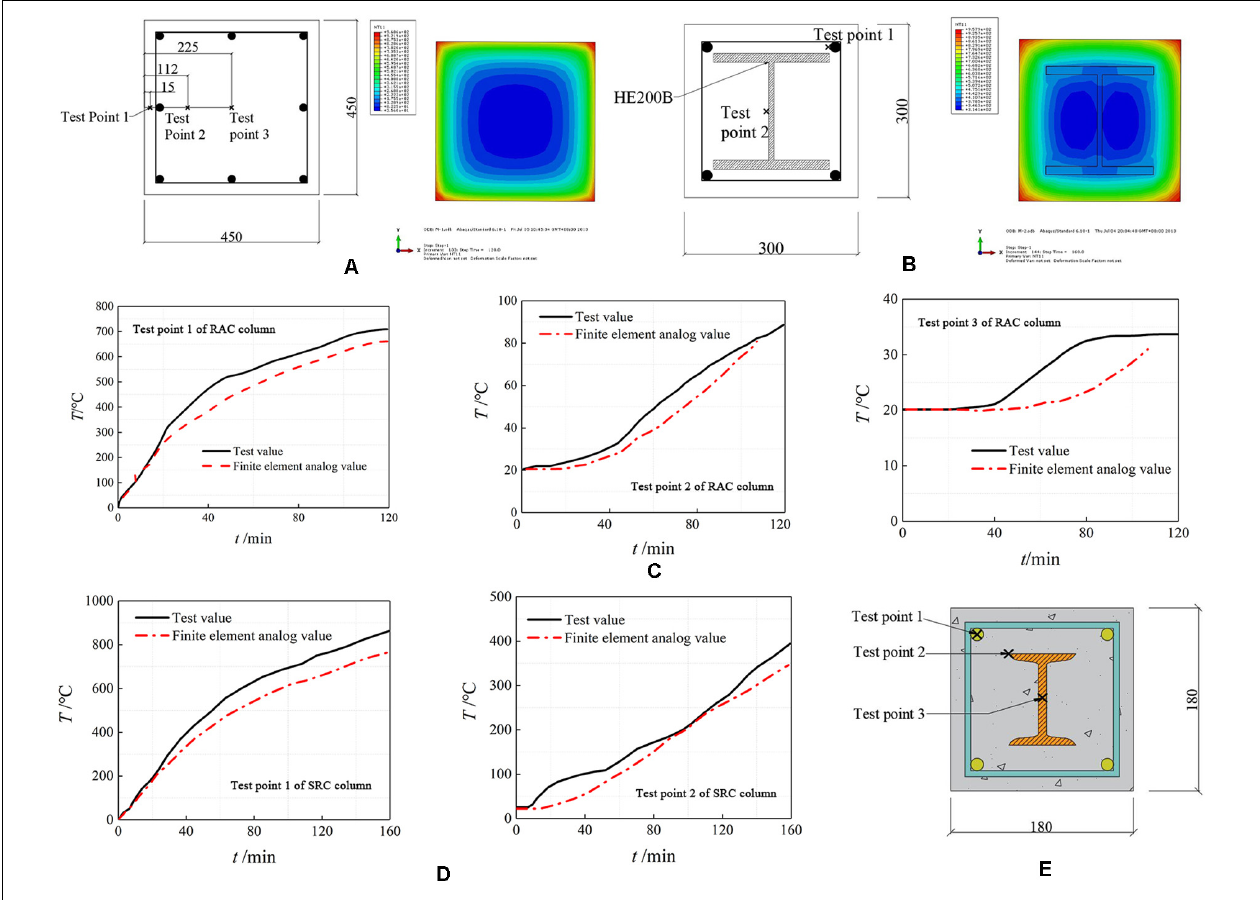
FIGURE 7 | Measure point arrangement and comparison of test and calculation temperature. (A) Section size, measure point arrangement and temperature field of RAC column. (B) Section size and measure point arrangement and temperature field calculation results of SRC column. (C) Comparison of test and calculation temperature of RAC column. (D) Comparison of test and calculation temperature of SRC column. (E) Measure point arrangement of